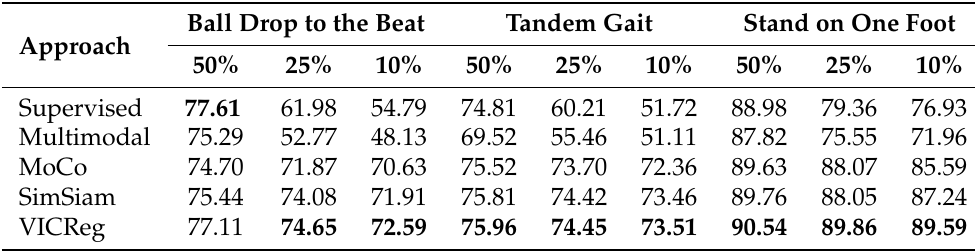
Table 2. Different methods’ top-1 classification accuracy for different training/test splits: 50%—using 50% of the dataset for training and the remaining 50% for testing; 25%—using 25% of the dataset for training and the remaining 75% for testing; 10%—using 10% of the dataset for training and the remaining 90% for